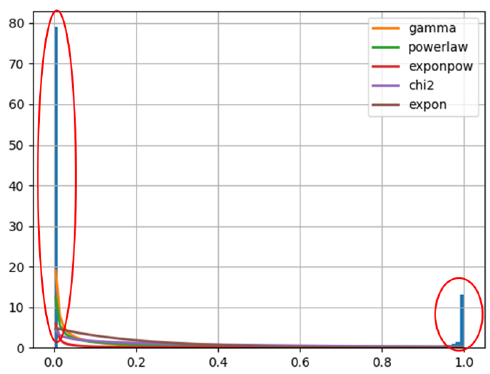
Figure 1. Fitted Distributions of G of